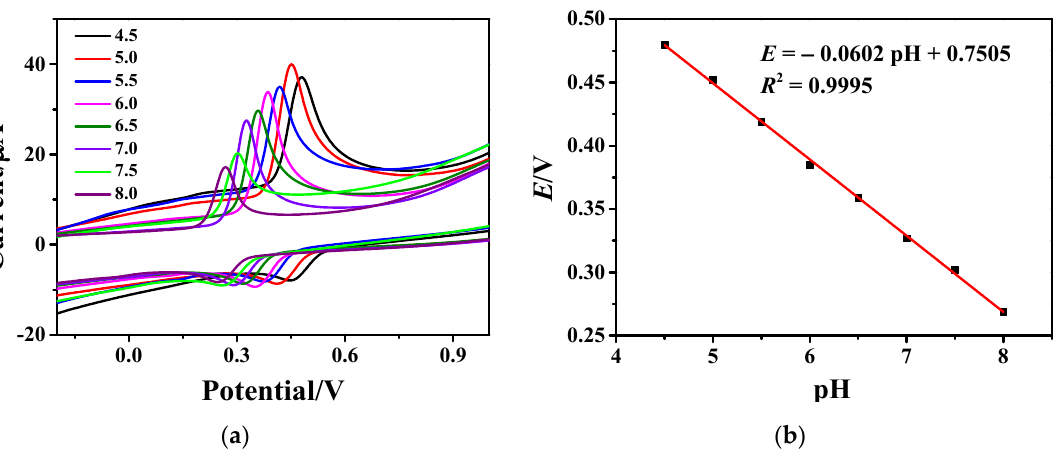
Figure 5. ( a ) CV curves of 1×10 − 4 M AC on Fe 3 O 4 -rGO/GCE electrodes at a scan rate of 100 mV·s − 1 in PBS buffer solution with different pH and ( b ) dependence of formal potential on pH value.